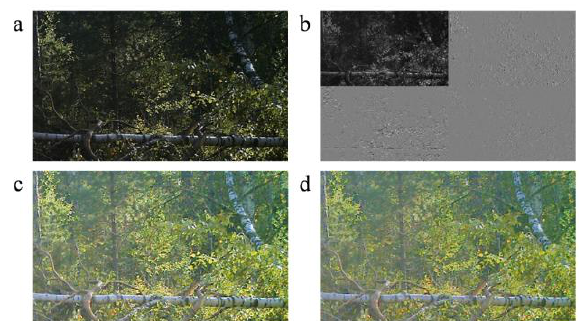
Figure 2. Example of the illumination enhancement of area with high local contrast: a) original image, b) wavelet transform, c) MSR result, d) MSR with wavelet transform modification